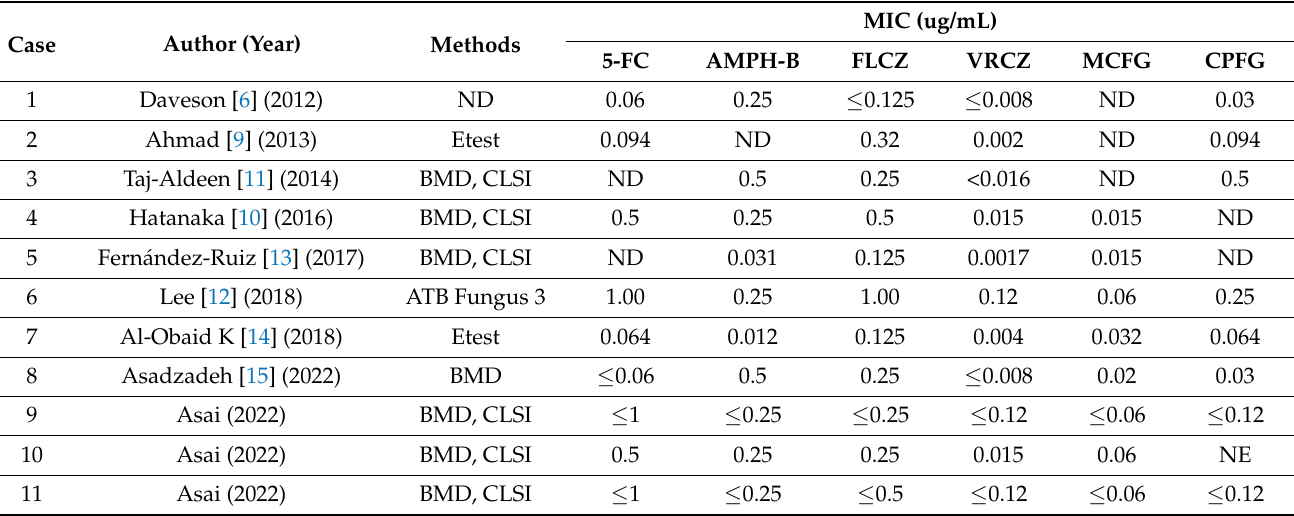
Table 2. Antifungal susceptibility profile of L. elongisporus